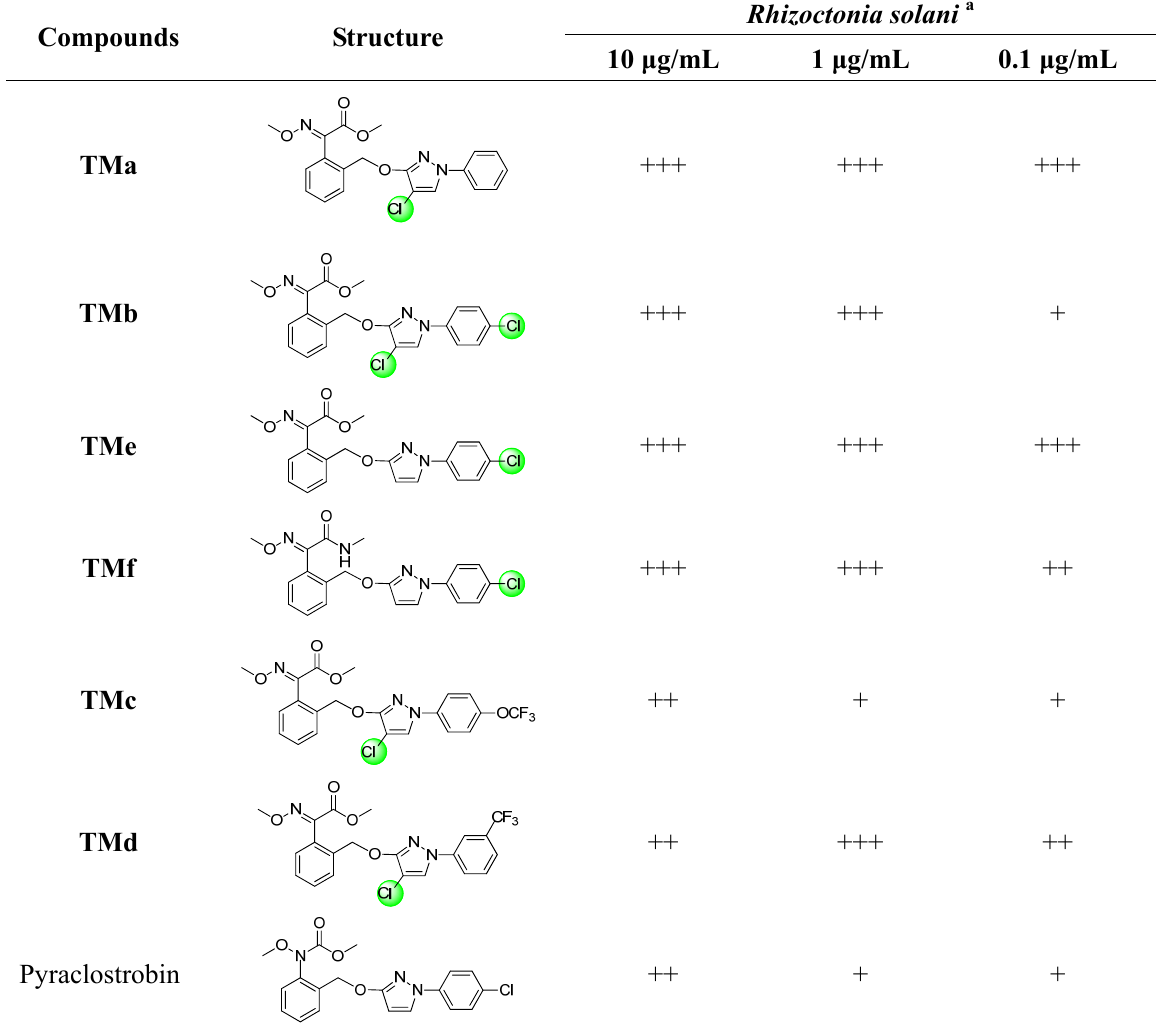
Table 1. Antifungal activity of tested compounds (% inhibition). Compounds